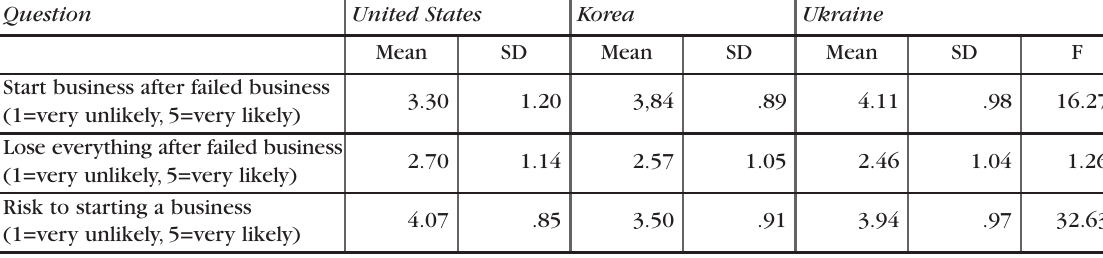
Table 8. New Venture Riskiness